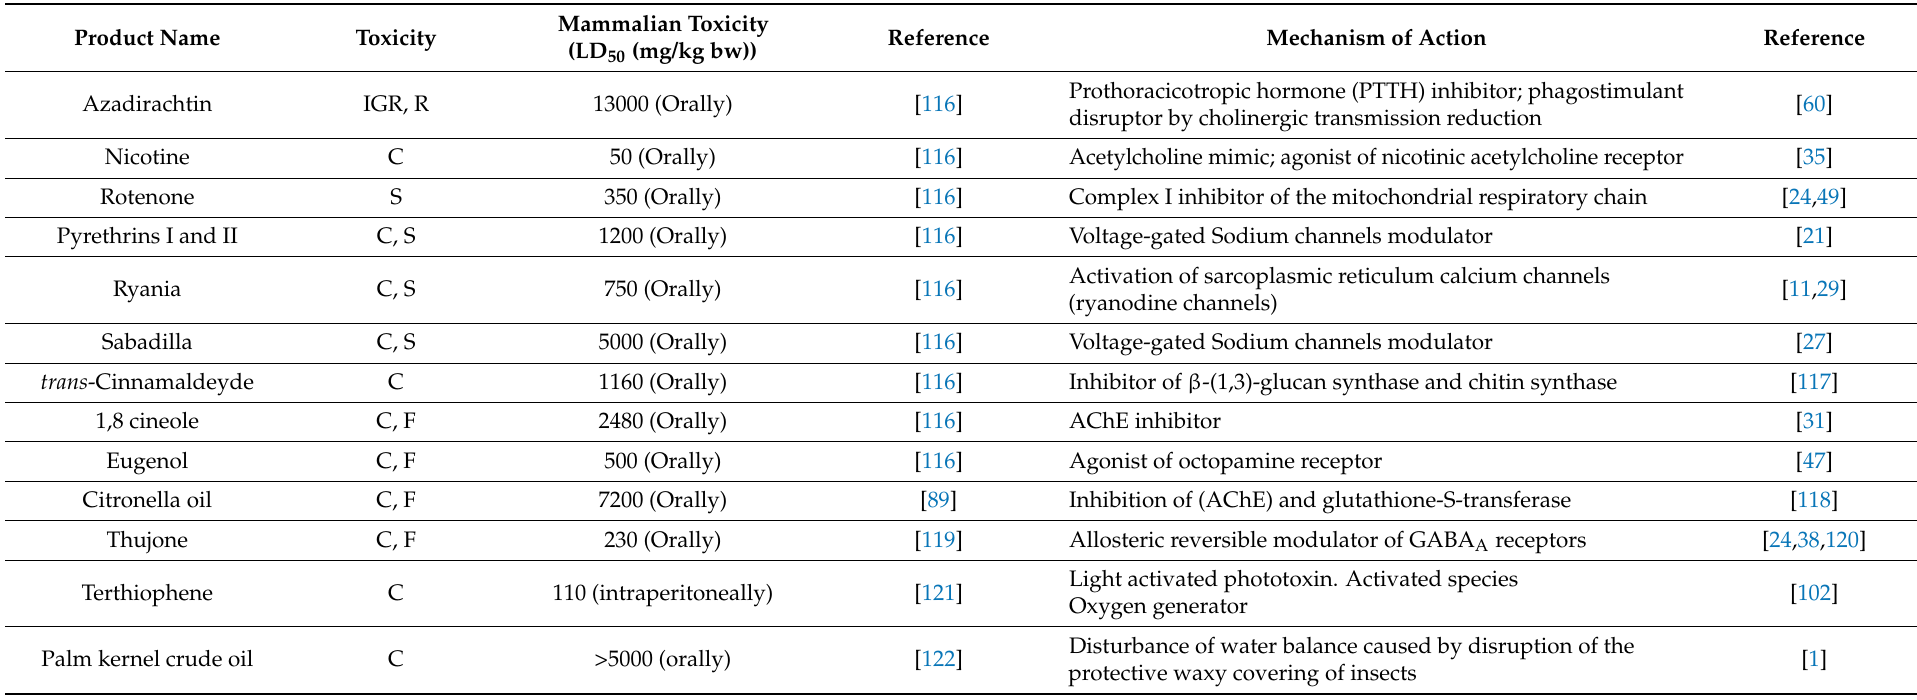
Table 1. Toxicity and mechanism of action of bio-based natural